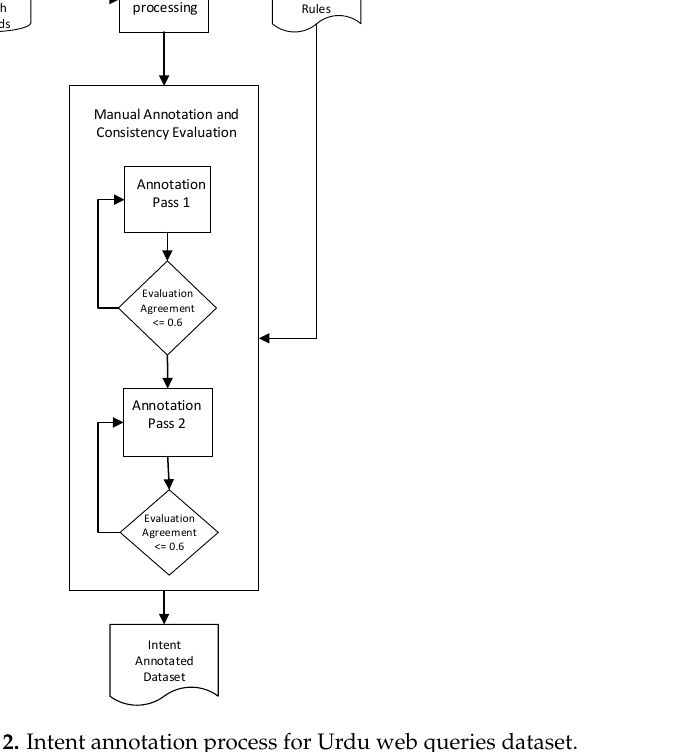
Figure 2. Intent annotation process for Urdu web queries dataset.